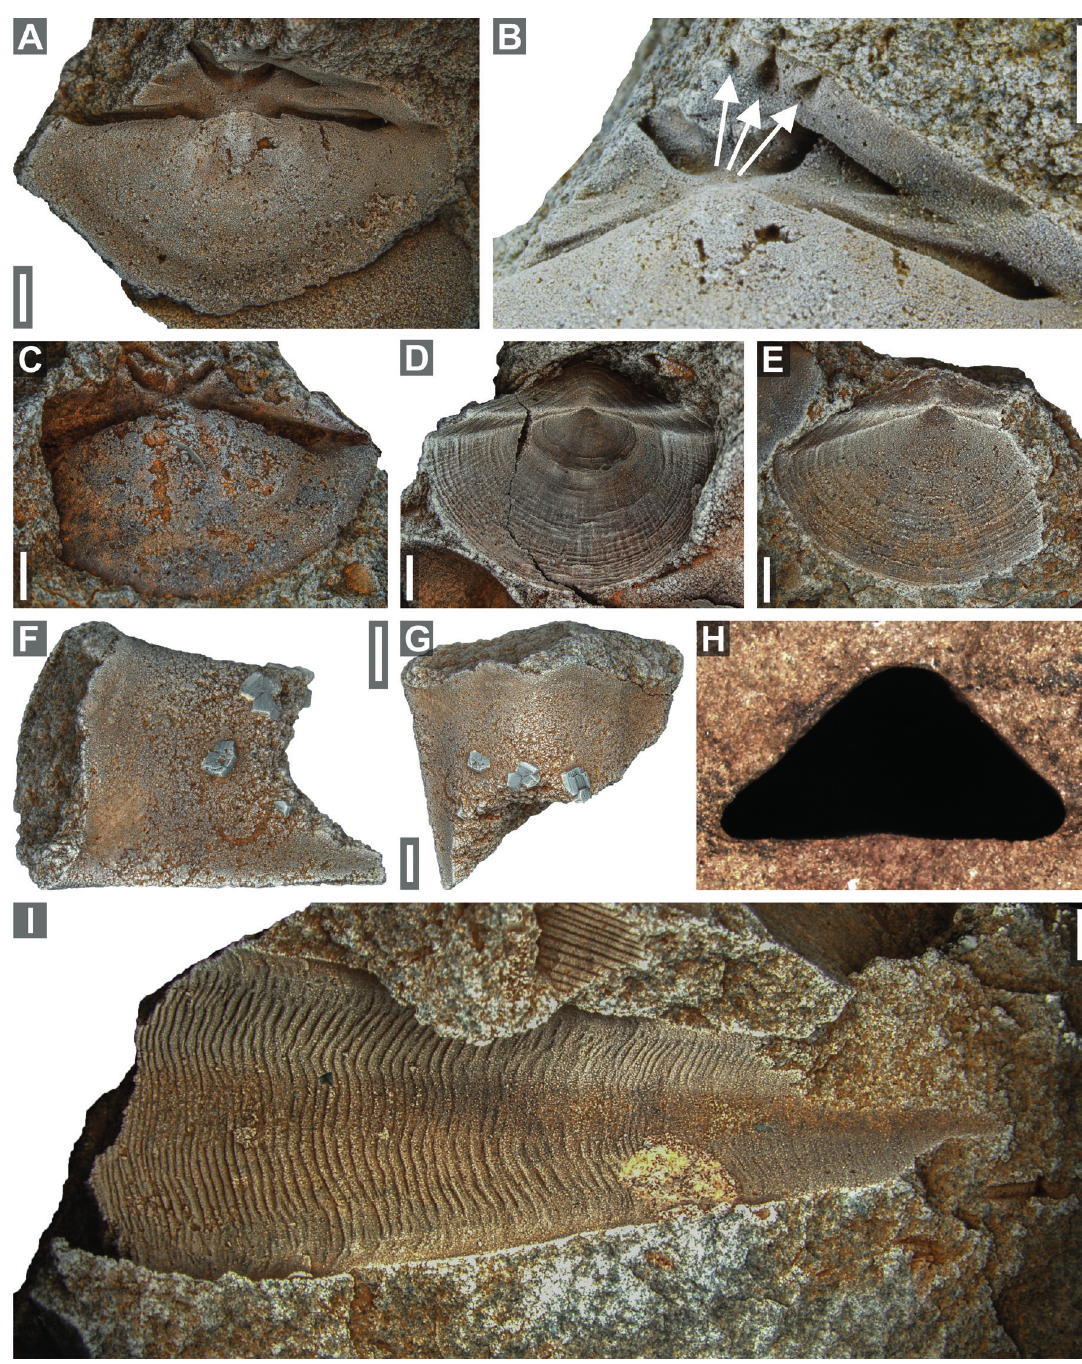
Fig. 2. Alfaites romeo gen. et sp. nov. A-B. Holotype (NM L46640). A. Outer mould of internal side of operculum. B. Detail of outer mould of internal side of operculum with marked cardinal teeth. C–I. Paratypes. C. Outer mould of internal side of operculum (NM L46642). D. Outer mould of external side of operculum (NM L46646). E. Outer mould of external side of operculum (NM L46641). F. Outer mould of apertural part of conch – lateral view (NM L46645). G. Inner mould of apertural part of conch – dorsal view (NM L46645). H. Subtrigonal cross-section of conch (NM L46643). I. Outer mould of dorsal side of conch with distinct asymmetrical ribs (NM L46644). Scale = 1